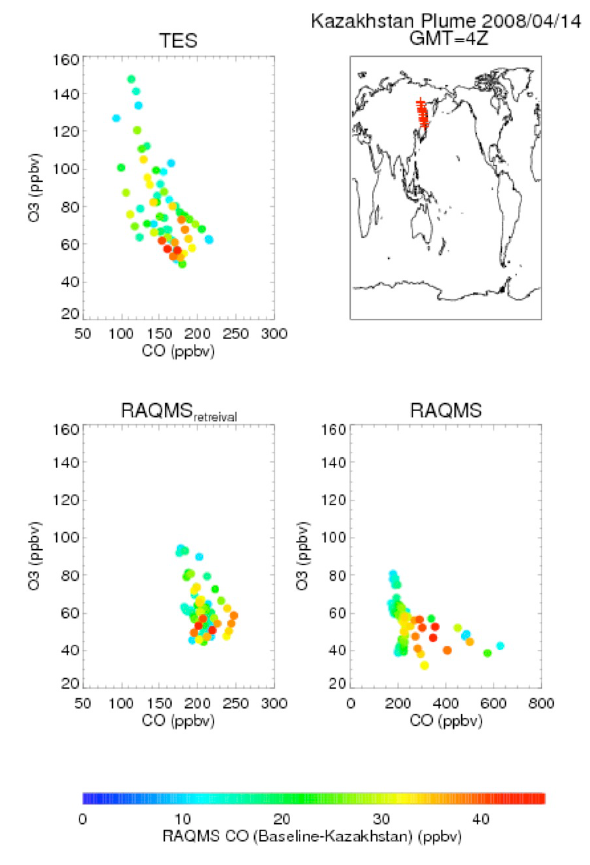
Fig. 8c. Same as Figs. 8a and b but near the DC9